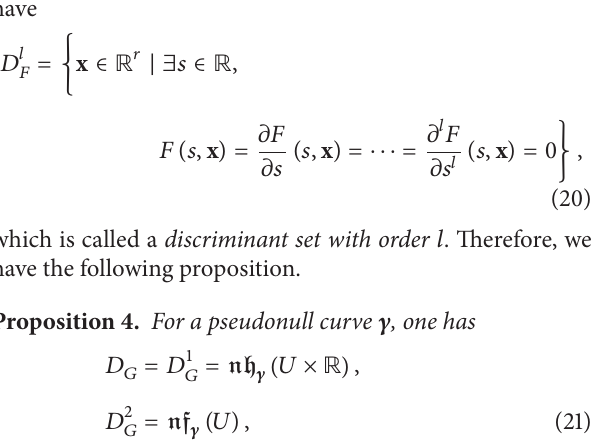
(𝑠, x ) . We say 𝑓 0 0